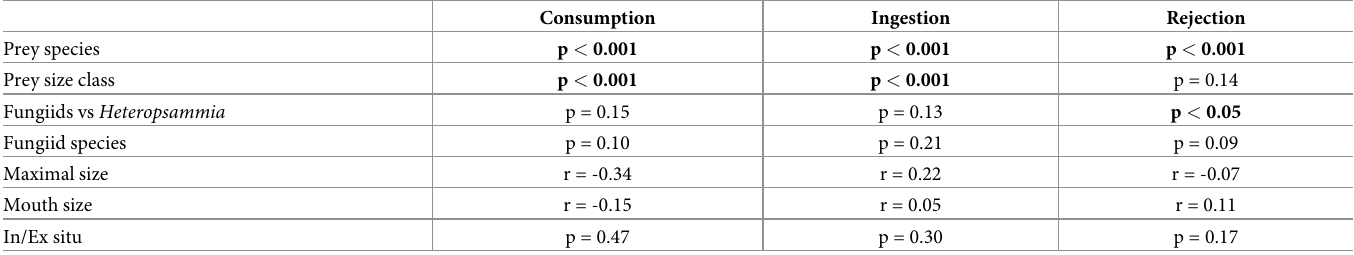
Table 4. Tests of significance and correlation between numerous variables with relation to consumption score, time to completed ingestion and time to completed rejection. Significant results were considered as those with p < 0.05 or r values > 0.5 with regards to correlation. Consumption Ingestion Rejection Prey species p < 0.001 p < 0.001 p <